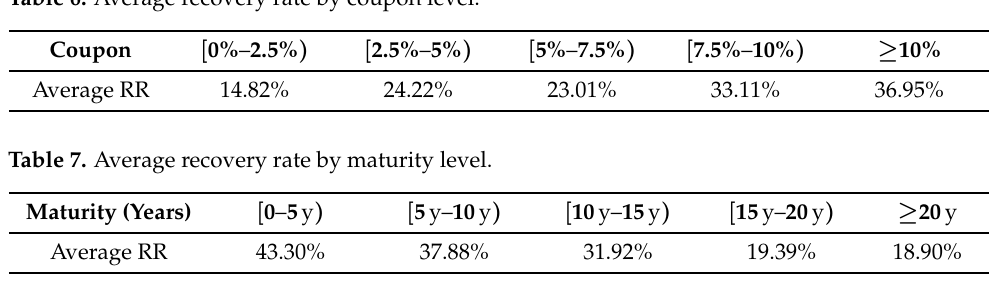
Table 6. Average recovery rate by coupon level.